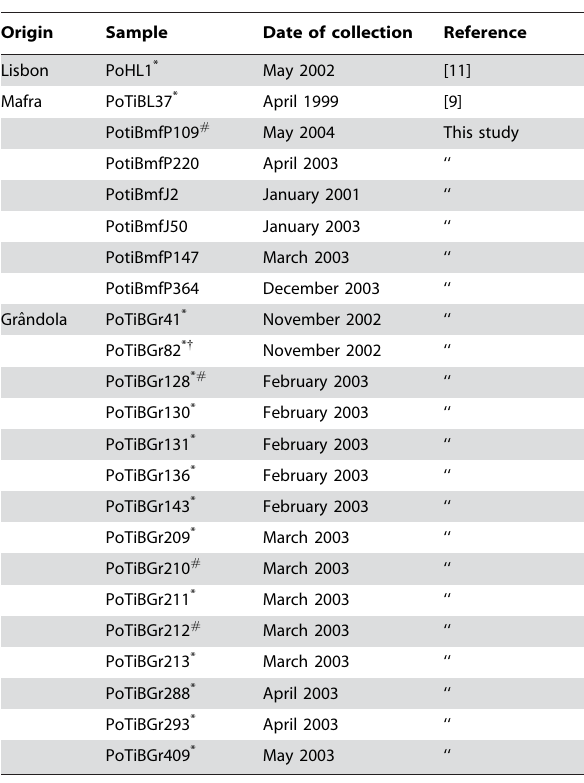
Table 1. B. lusitaniae samples analyzed in this